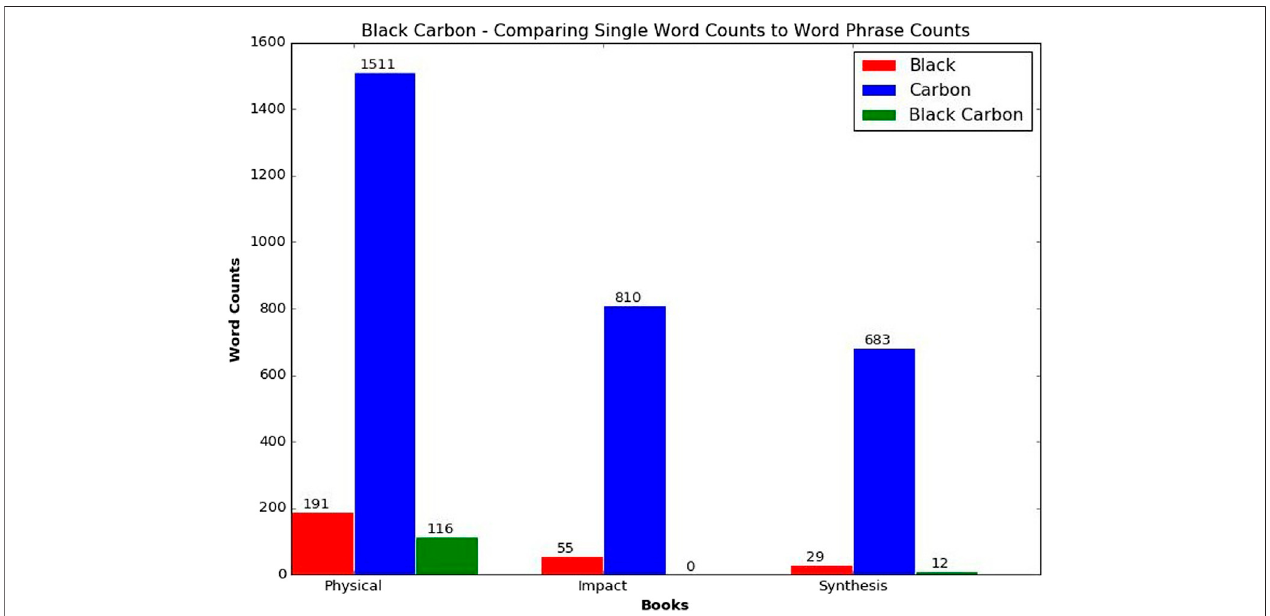
FIGURE 1 | Comparing word counts and phrase counts for black carbon among the intergovernmental panel for climate change books assessment report 3 (Sleeman et al., 2018).